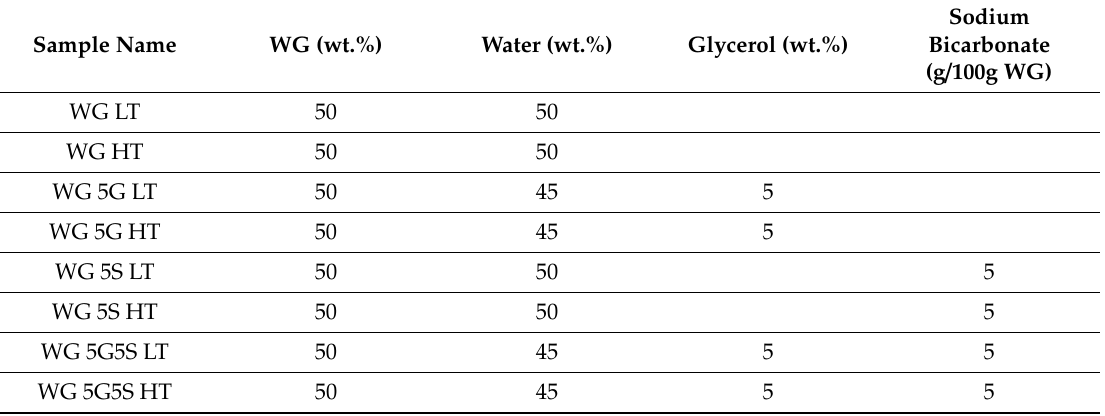
Table 1. Table 1. Sample formulations and the extrusion parameters used.